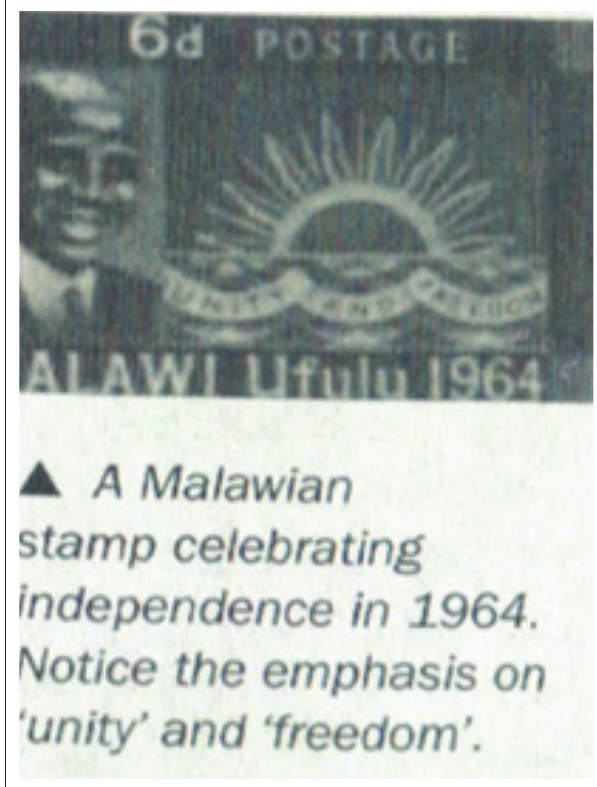
Source : Textbook 4 , p. 78 FIGURE 2: A Malawian postage stamp showing the date 1964.